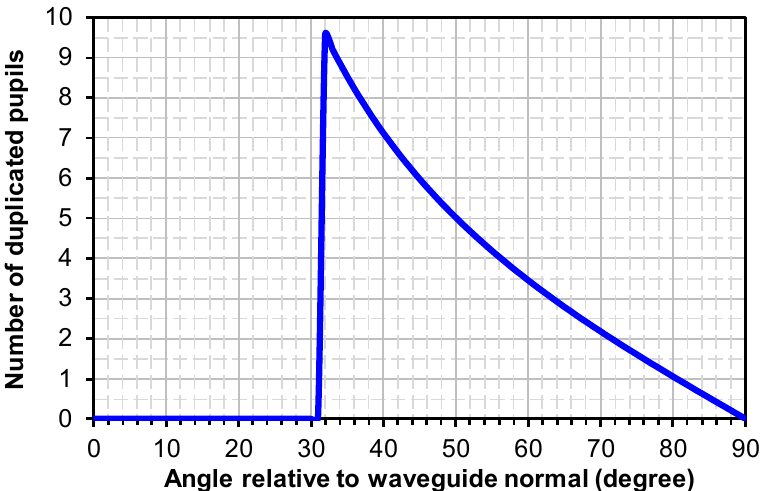
Figure 3. Number of duplicated pupils with respect to the angle relative to the waveguide normal. When θ wg < θ c (31.57°), TIR does not occur. When θ wg ≥ θ c , the number of TIRs decreases all the way to 0. Say the number of duplicated pupils is supposed to be no less than 5. Then, the upper limit of field θ max will max out at 50°.